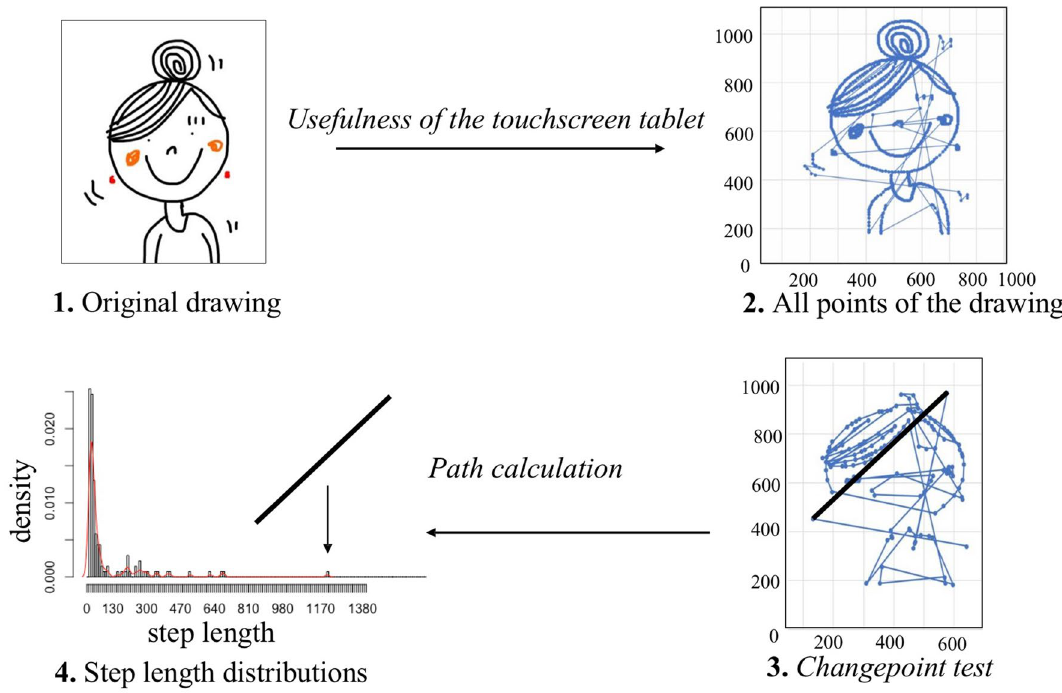
Figure 6. Schema of the different analytical stages for a drawing. All the points of a drawing were extracted from the original one. The application of the changepoint test enabled us to use a reduced number of points; step length distribution was then analyzed. The step length (thick black line) in stage 3 is transferred onto the graph in stage 4. Isabelle Jacqué drew the original